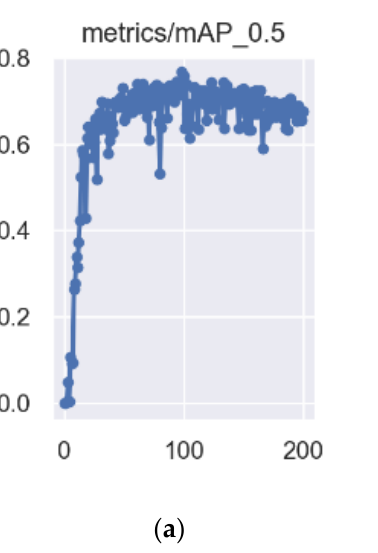
Figure A8. The precision/recall curve and F 1 Score /confidence curve of YOLOV5m ( a ) PR_curve; ( b ) F1_curve.